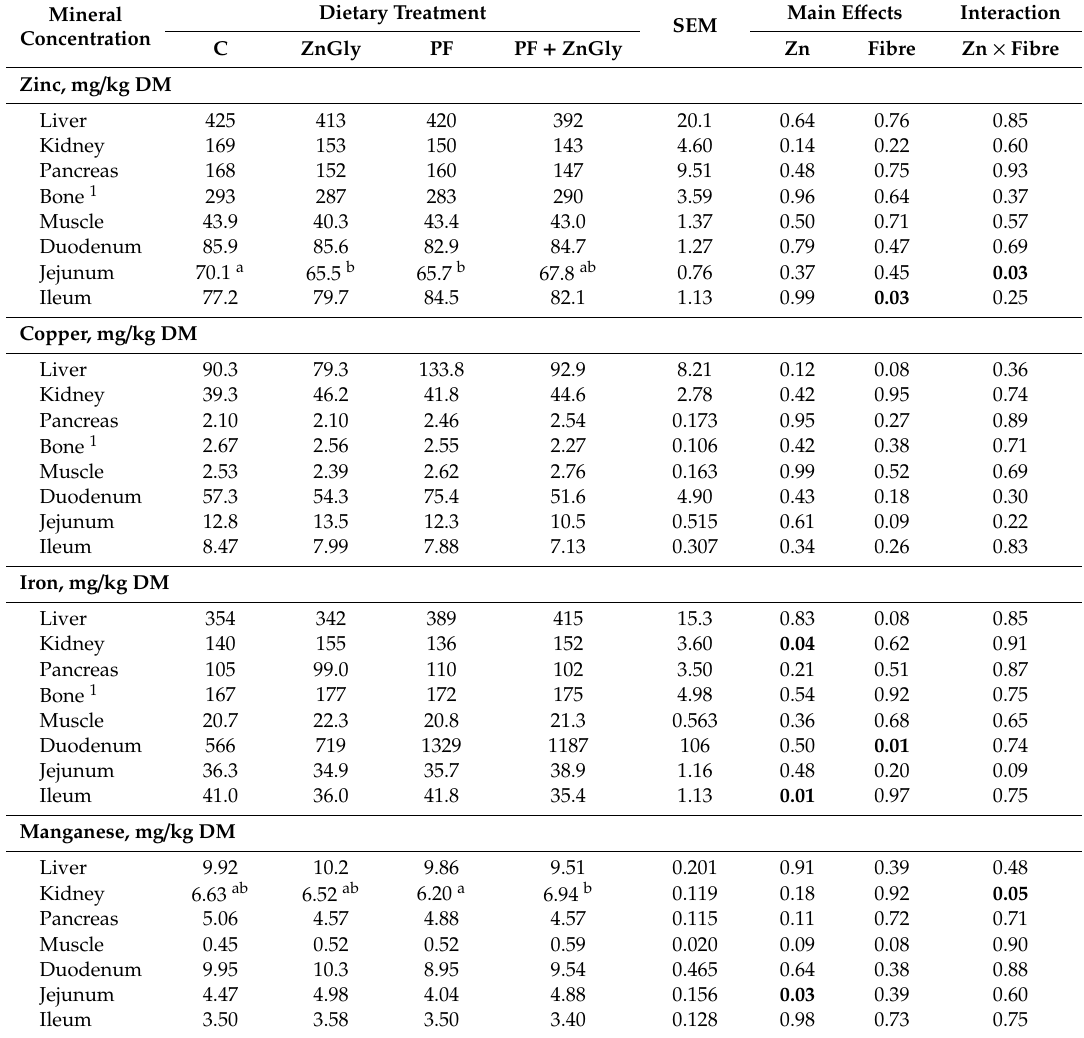
Table 3. Tissue Zn, Cu, Fe and Mn concentrations of piglets fed diets di ff ering in zinc and fibre